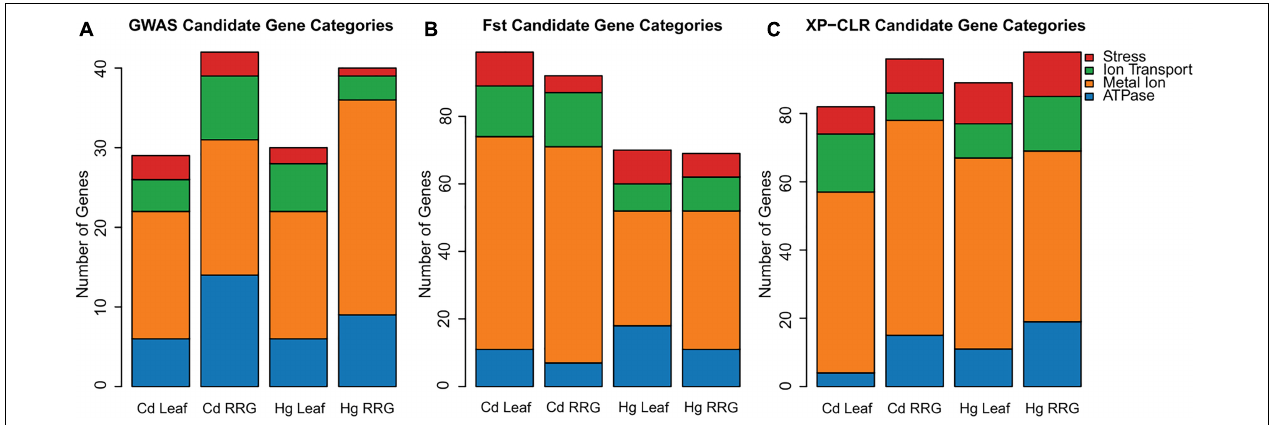
FIGURE 3 | The number of genes with annotations in categories for ATPase, ion transport, metal ion, and stress related genes within 1 kb of the 1000 most significant SNPs using GAPIT for each of the four traits (A) . The number of genes in these four categories in the upper 2% of the highest F st sliding windows (B) , and the number of genes with these four categories in the 2% of sliding windows with highest XP-CLR-values (C) . The y -axis represents the number of genes in each